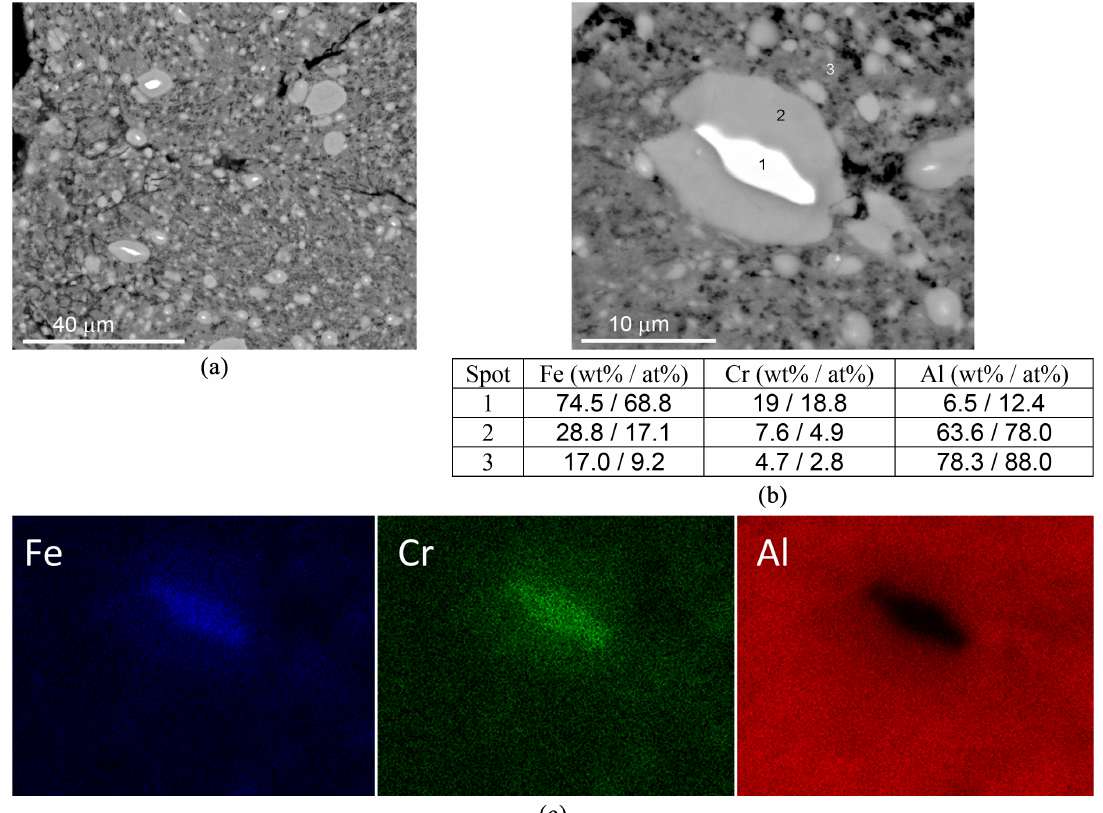
Figure 6. (a) and (b) Backscattered image of a Al_10 vol.% MA956 composite powder heated up to 570 °C. Inserted table in (b) presents the EDS results obtained from spots 1, 2 and 3. (c) EDS mapping showing the distribution of Fe, Cr and Al in the region of Figure